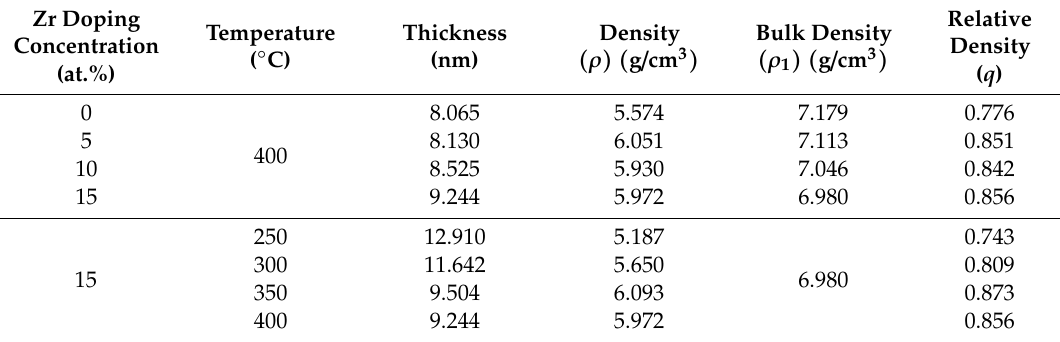
Table 1. Measurement results of In 2 O 3 thin film with different doping concentrations of zirconium and different temperatures.